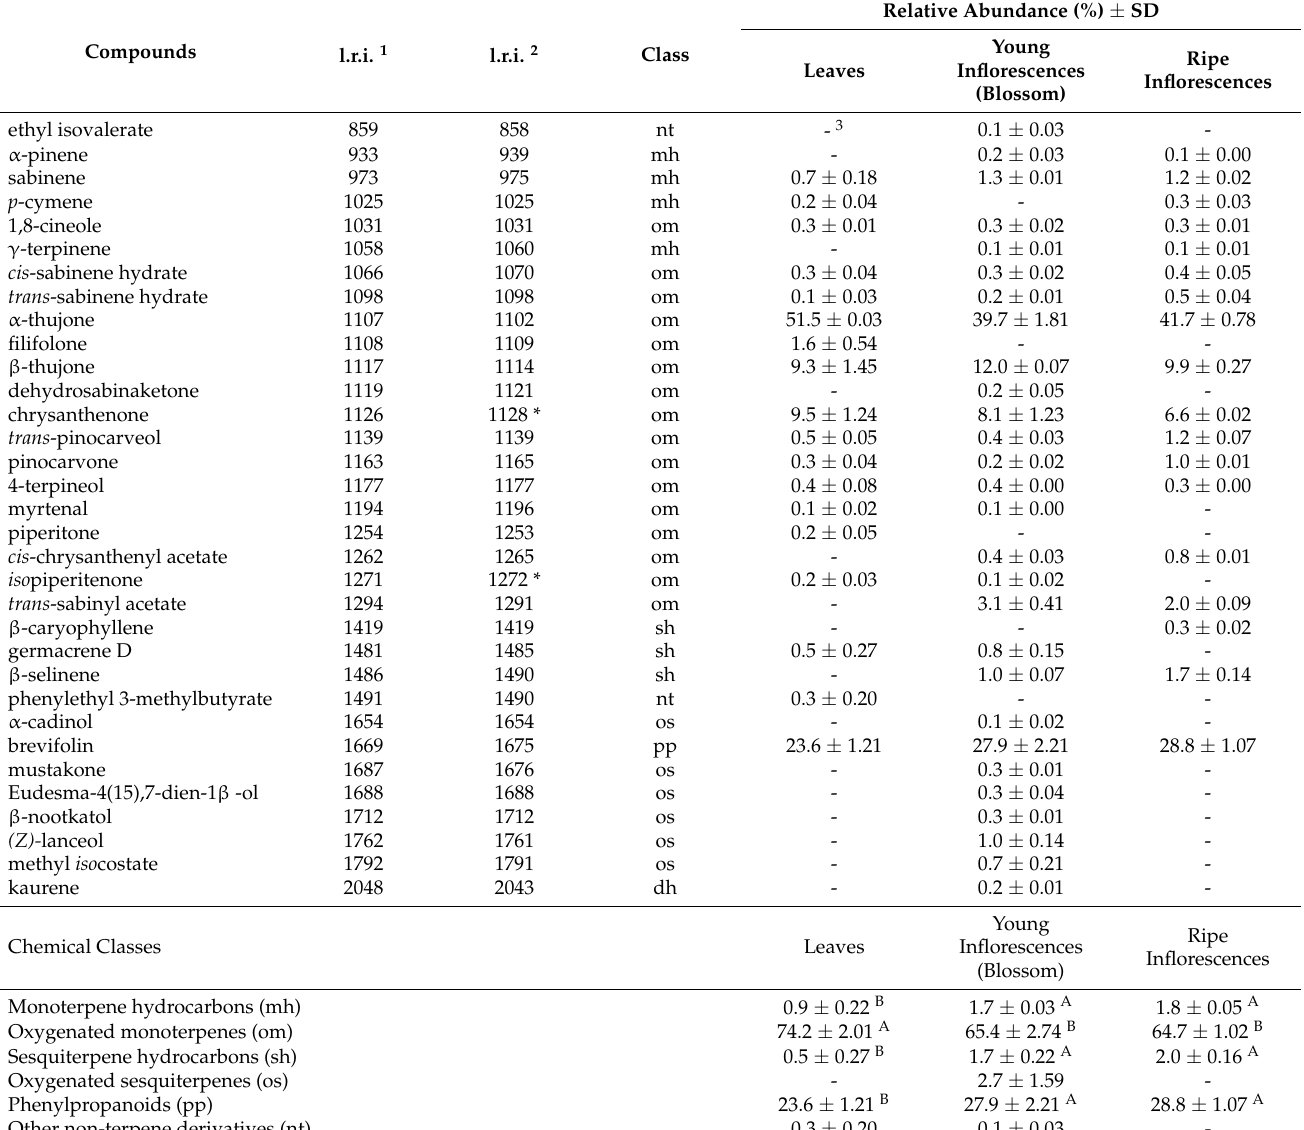
Table 4. Complete chemical composition and hydrodistillation yield of the essential oils obtained from fresh leaves and young and ripe inflorescence samples of A. caerulescens ( n = 3; ± SD).